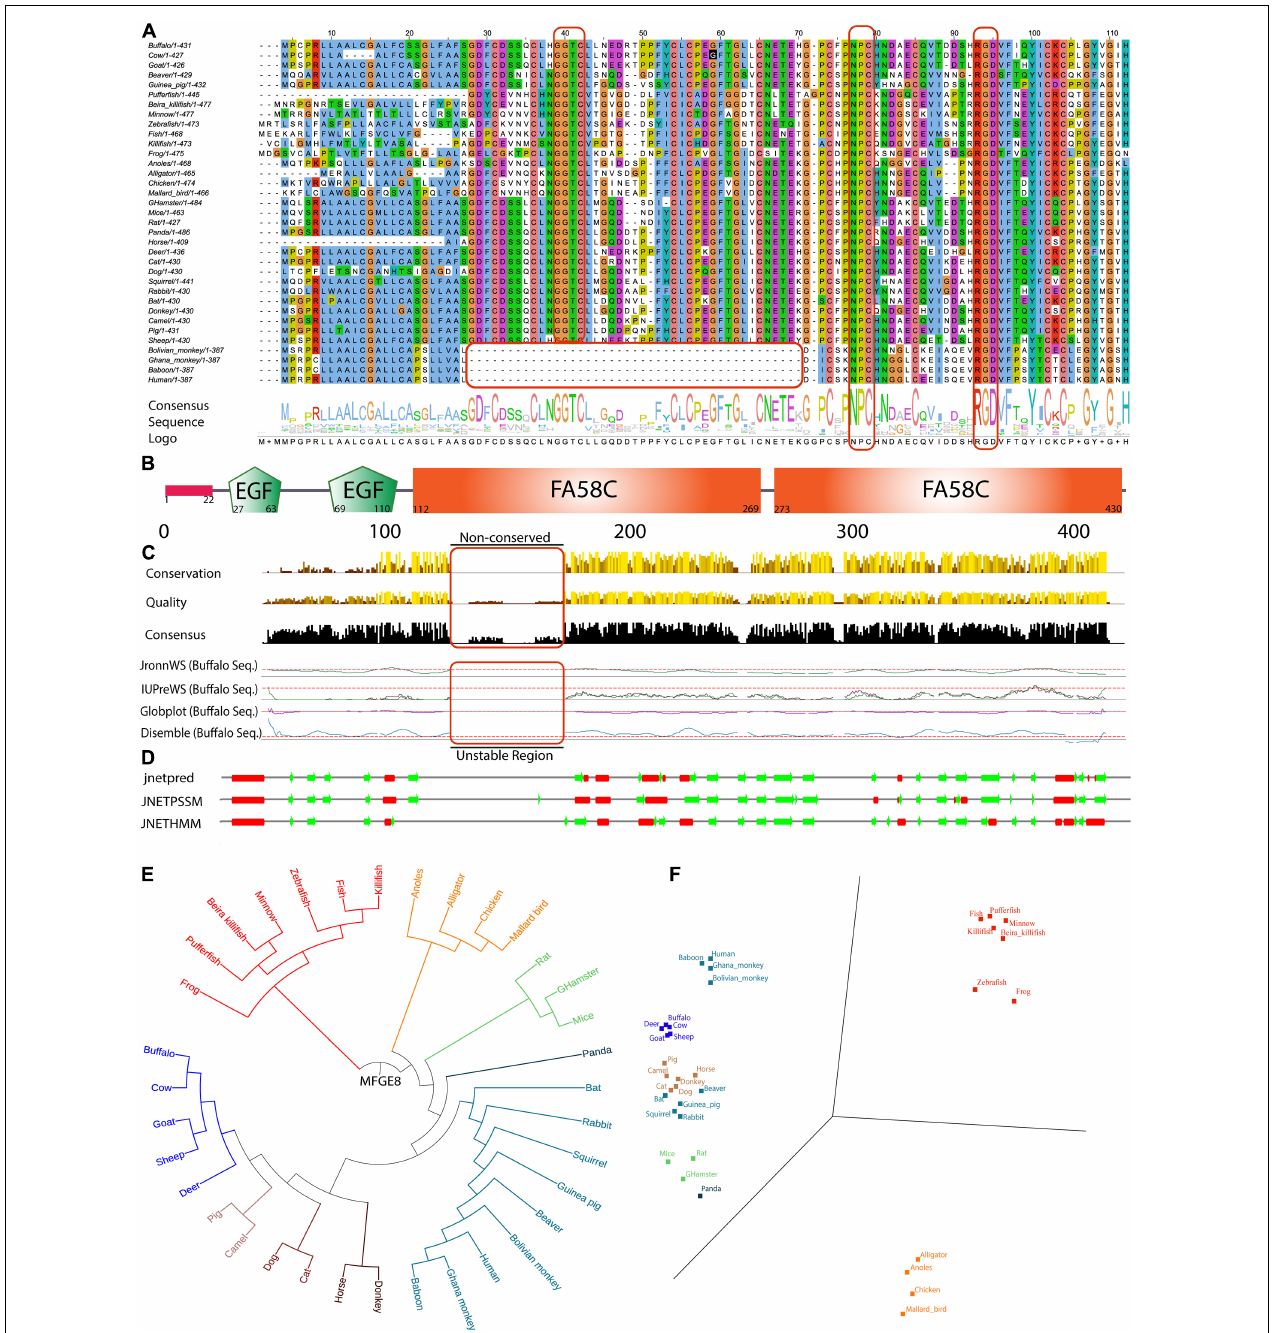
FIGURE 1 | In silico based MFGE8 protein sequence characterization. (A) Multiple sequence alignment (MSA) of 35 organisms used from UniProt non-redundant and reviewed database. Total numbers of amino acid residue present in the individual sequence were reported in front of the organism name, and MSA is clustal color-coded. The consensus sequence logo was shown in the downside of the alignment, and the conserved nature was depicted using the size of the amino acid single alphabet symbol. (B) The structure of the MFGE8 protein containing the complete common domains observed in all programs. (C) The full-length sequence quality, conservation, and consensus nature of MSA are shown in comparison with 35 organism-specific MFGE8 protein. The buffalo specific MFGE8 protein sequence disordered behavior was analyzed using four algorithms (JronnWS, IUPreWS, Globplot, and Disemble), keeping the parameter defaults for all of them. The graph showed consistent results among the programs. (D) The secondary structure was predicted for a full-length MFGE8 sequence with the help of three independent programs (jnetpred, JNETPSSM, and JNETHMM). The red mark shows the α -helical structures, while the green arrows show the β -sheets structures in the MFGE8 protein. (E) Phylogenetic tree analysis of all 35 organisms used using distance tree. (F) Principal component analysis of MSA for all 35 organisms using BLOSUM 62 algorithm.